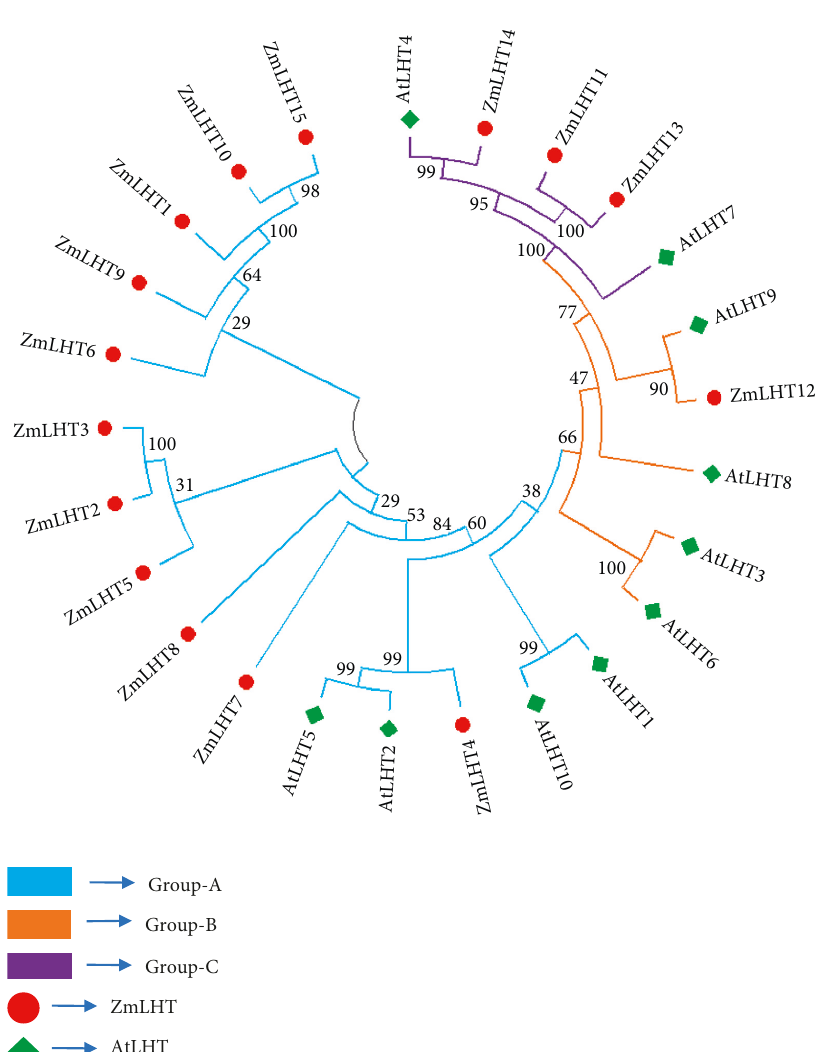
Figure 1: Analysis of phylogenetic tree of LHT gene family in maize.